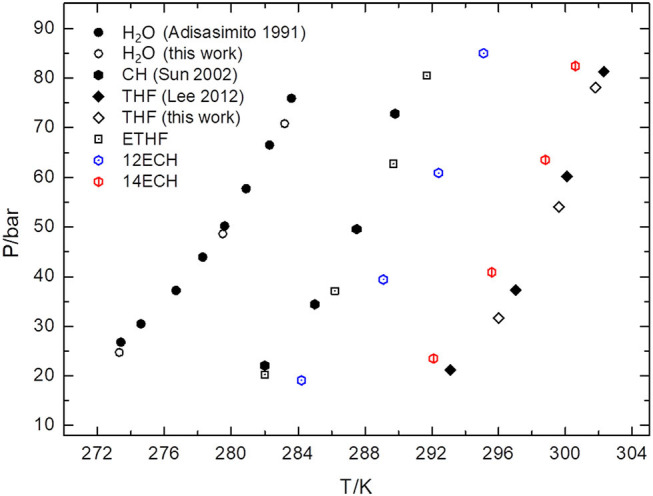
Equilibrium P-T conditions of CH4 hydrates containing various promoters (xLGM = 0.0556).